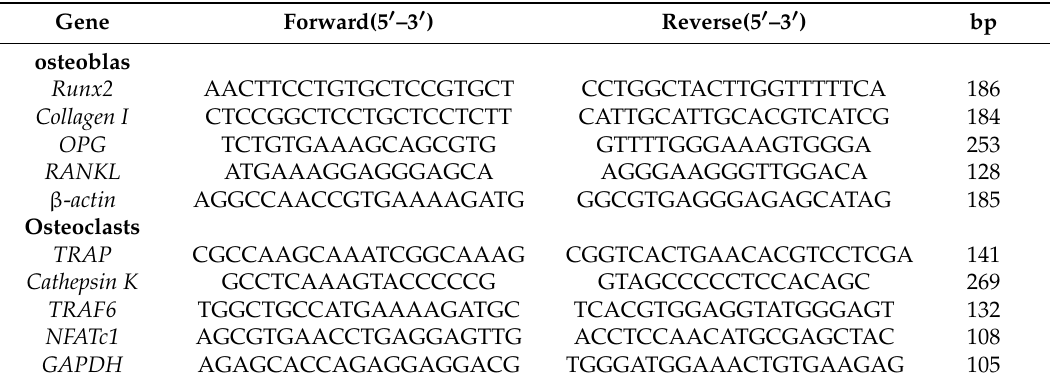
Table 1. Primers for real-time